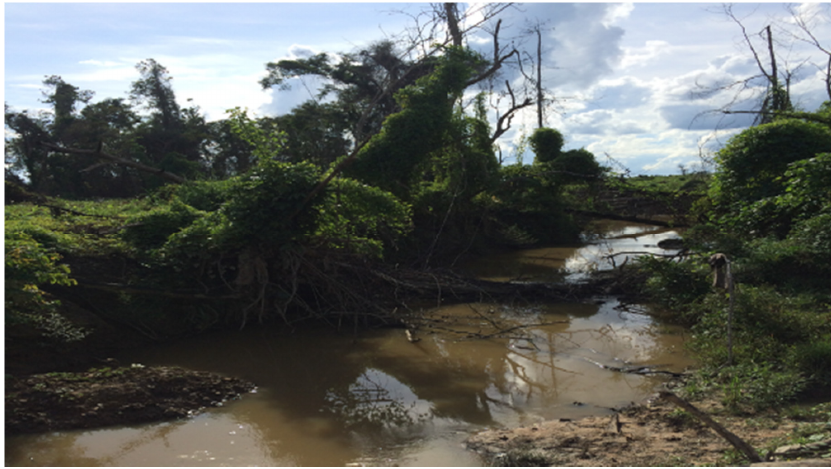
Figure 7. Stream O Sro Lork in the rainy season, 9.7.2016. Photo by Seay Monyrath.